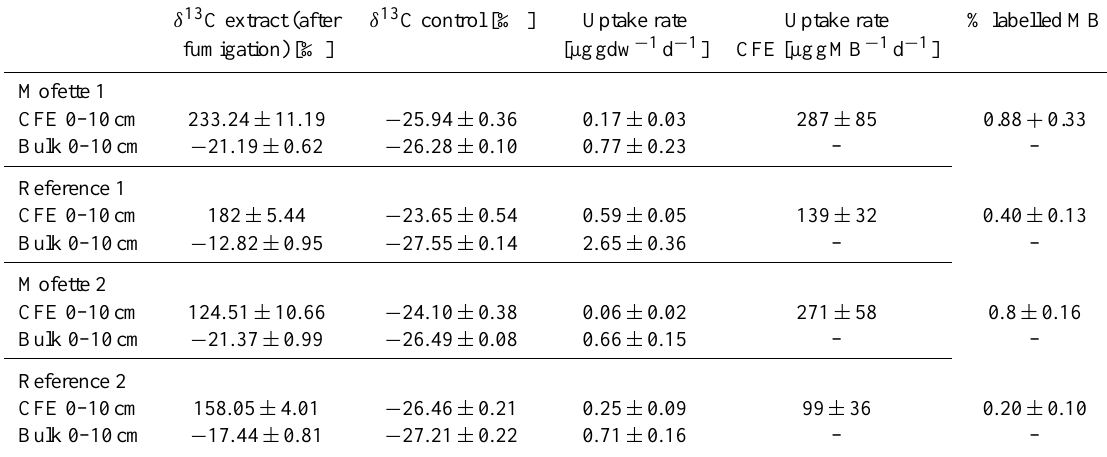
Table 2. Microbial biomass C and comparison of uptake rates determined during experiment 1 with CFE and bulk measurements. Uncertain- ties represent ± 1 σ standard deviation ( n = 3).